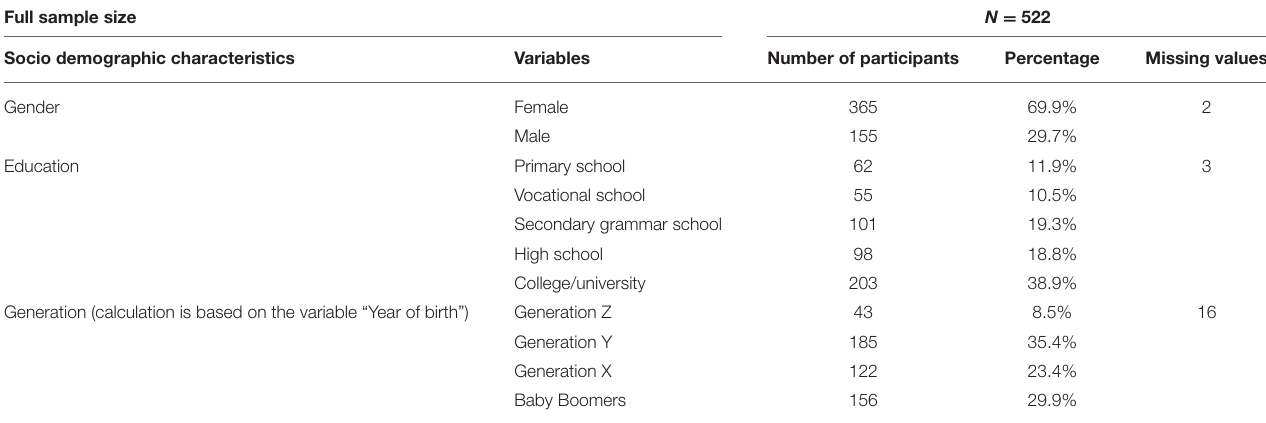
TABLE 1 | Socio-demographic characteristics of the sample ( N = 522).